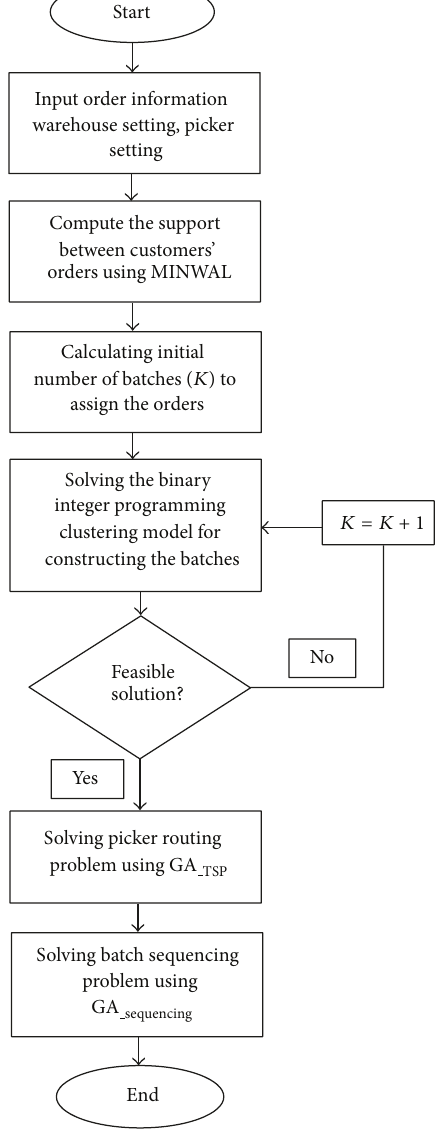
Figure 6: Methodology